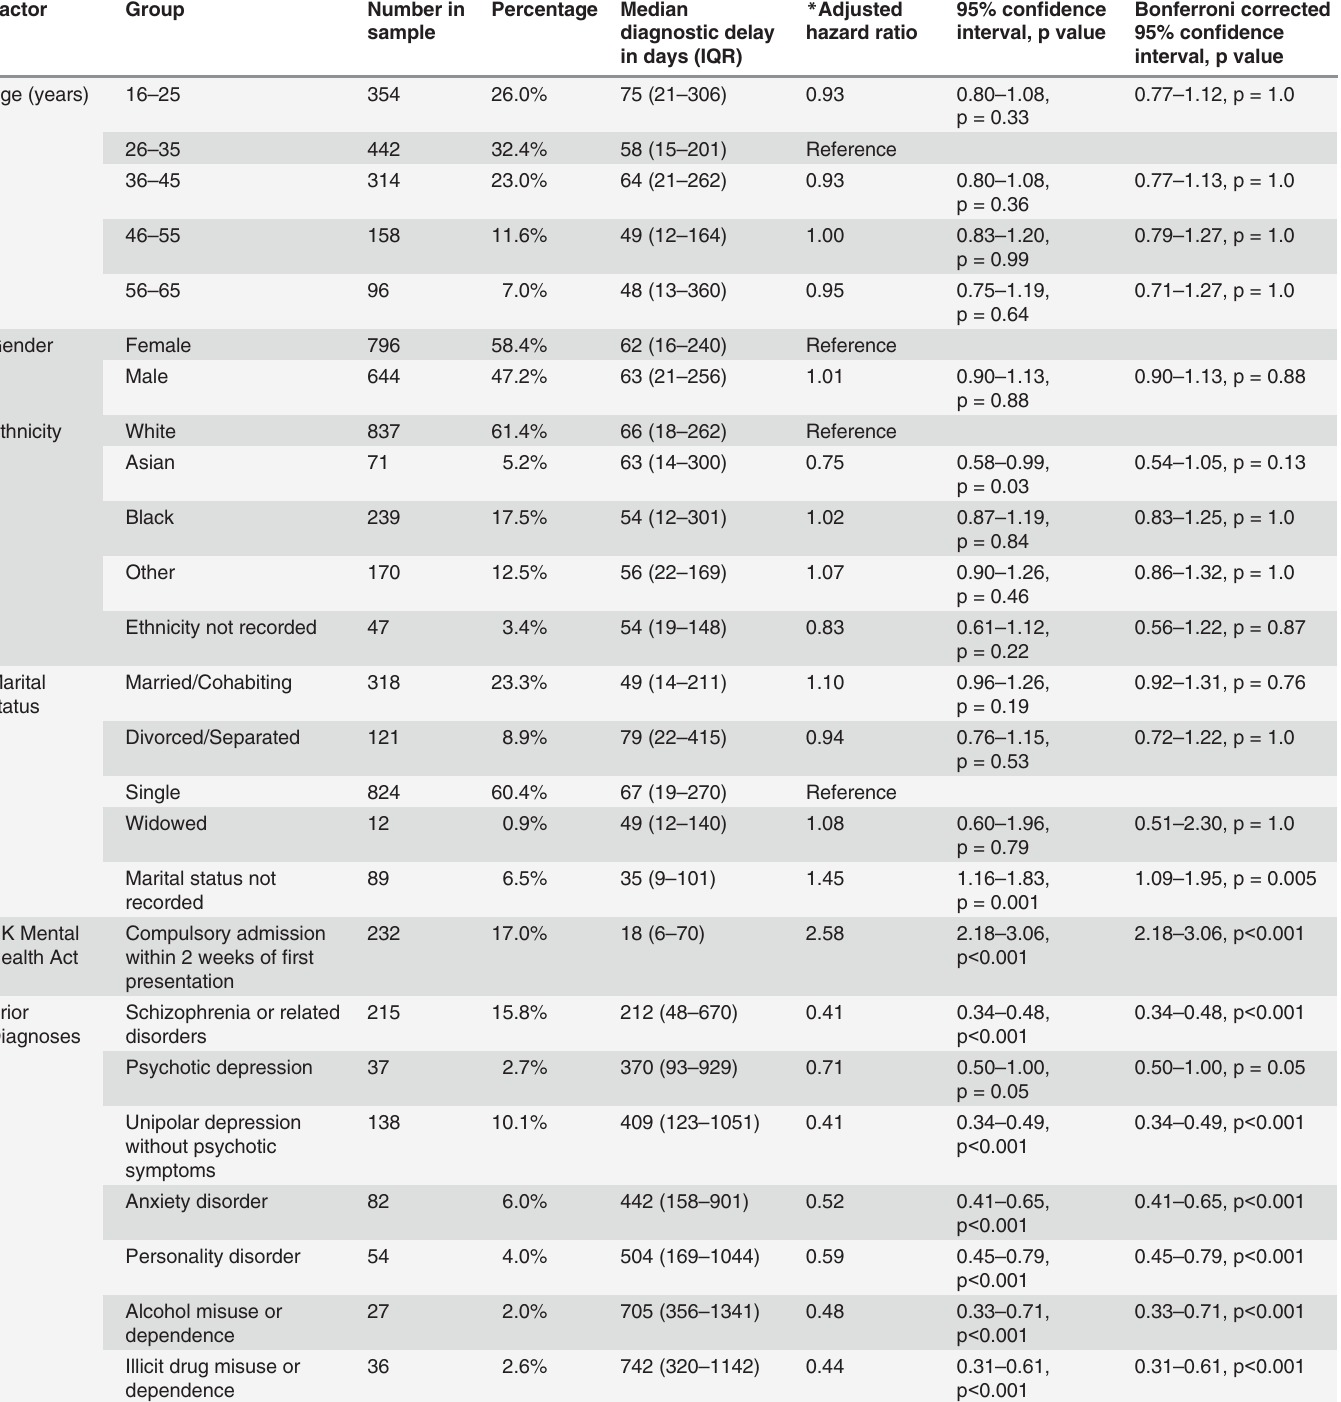
Table 1. Factors associated with bipolar disorder diagnostic delay (n =